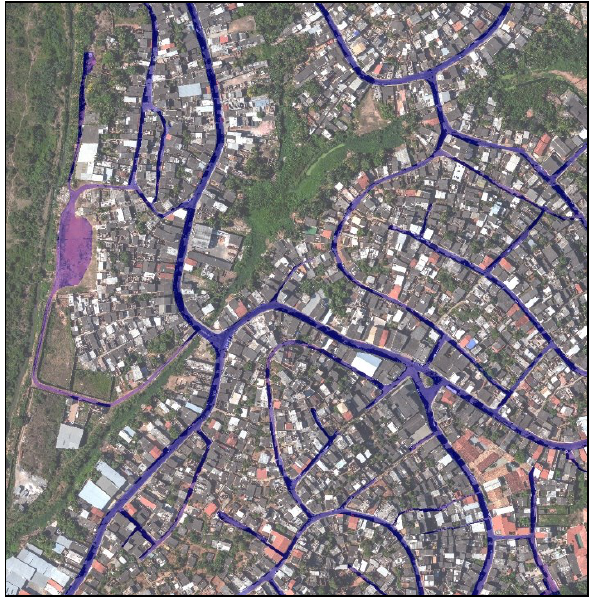
Figure 2 . da Paz neighborhood with road network in blue.